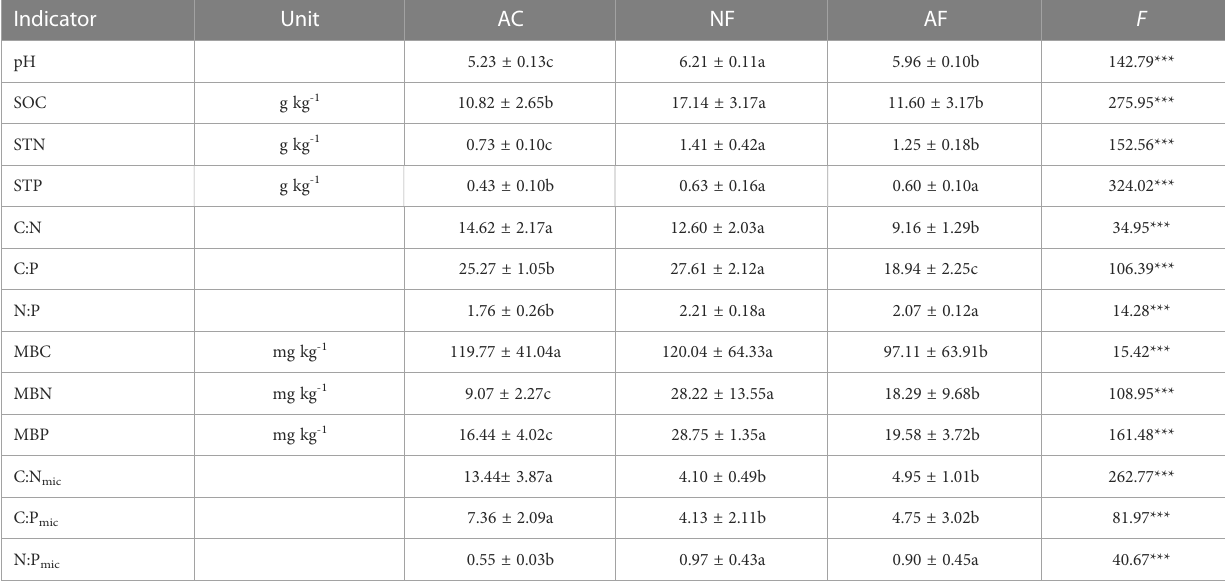
TABLE 1 Soil physicochemical properties for each vegetation restoration type.